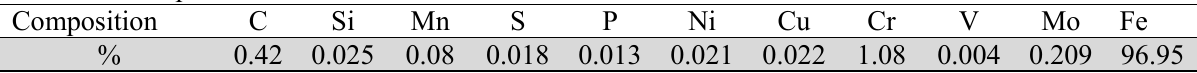
Chemical composition of AISI 4140 steel.